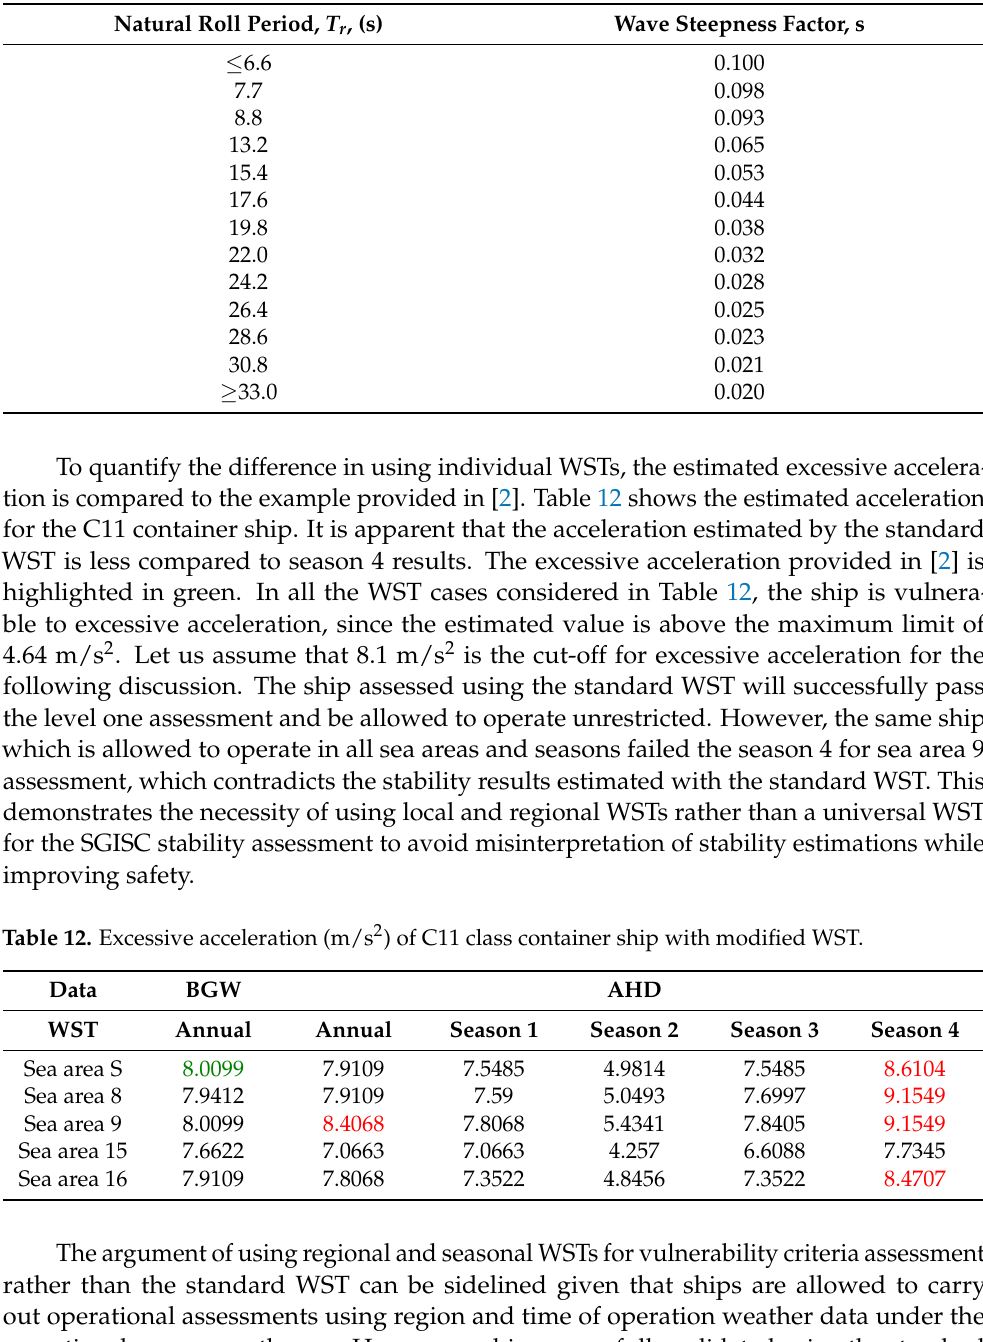
Table 11. Wave steepness table AHD data (season 4).